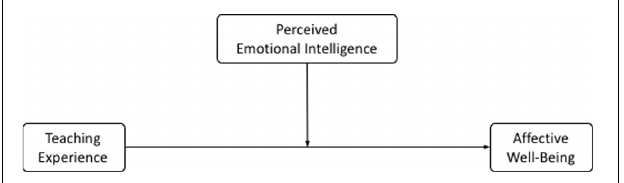
FIGURE 1 | The conceptual moderation